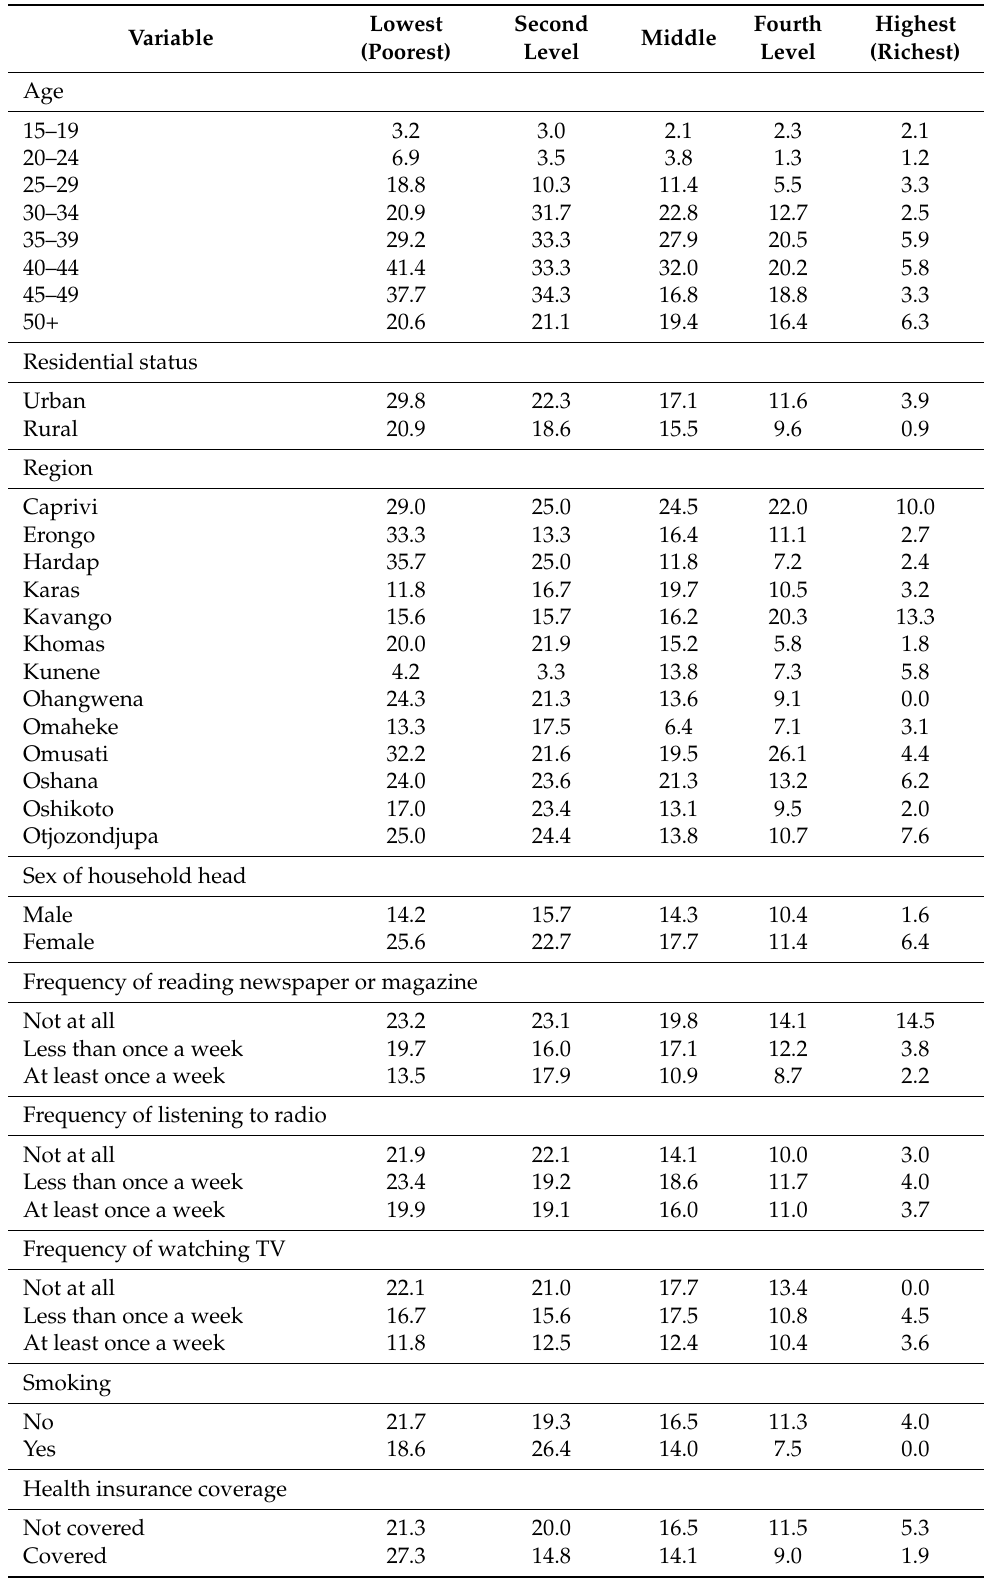
Table 3. Distribution of HIV prevalence by household wealth across women’s characteristics in